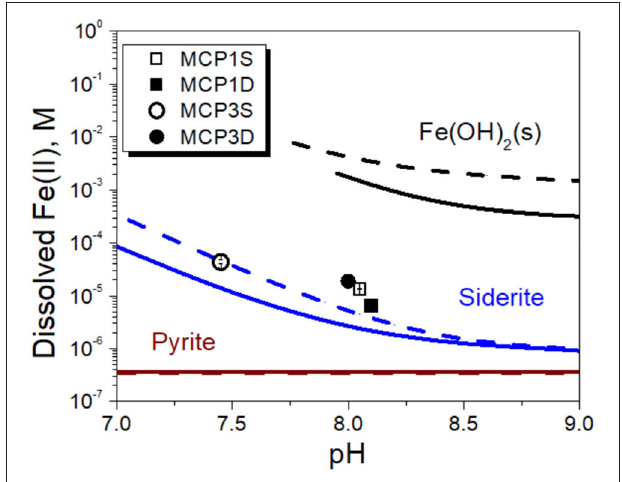
FIGURE 6 | Dissolved Fe(II) concentrations (symbols) vs. solubilities of amorphous Fe(OH) 2 (s), siderite and pyrite in the absence of Fe(II)-NOM complex (solid lines calculated at p CO2 = 10 − 2.0 atm and dashed lines calculated at p CO2 = 10 − 2.7 atm).